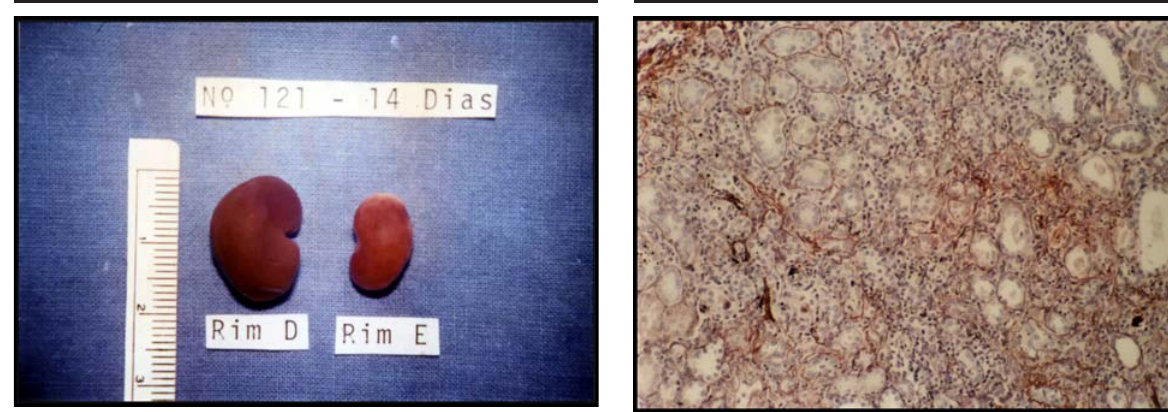
FIGURE 5 - Moderate tubular atrophy and intense interstitial infiltrate. Left kidney from GI at the time 3 (21 days). PASM, 100 X.